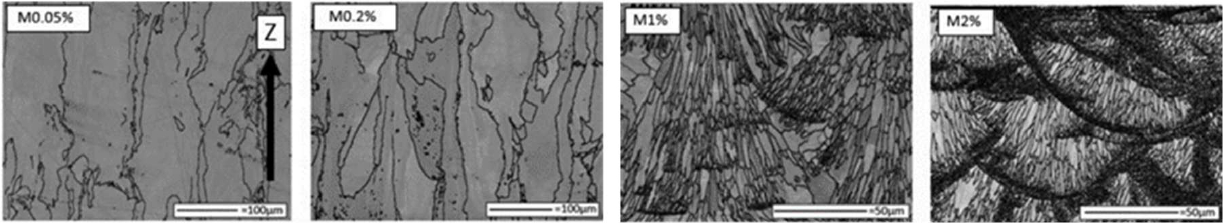
Figure 21. Electron Back-scattering Pattern (EBSD) images exhibit microstructures according to the volumetric quantity of added YSZ [109].